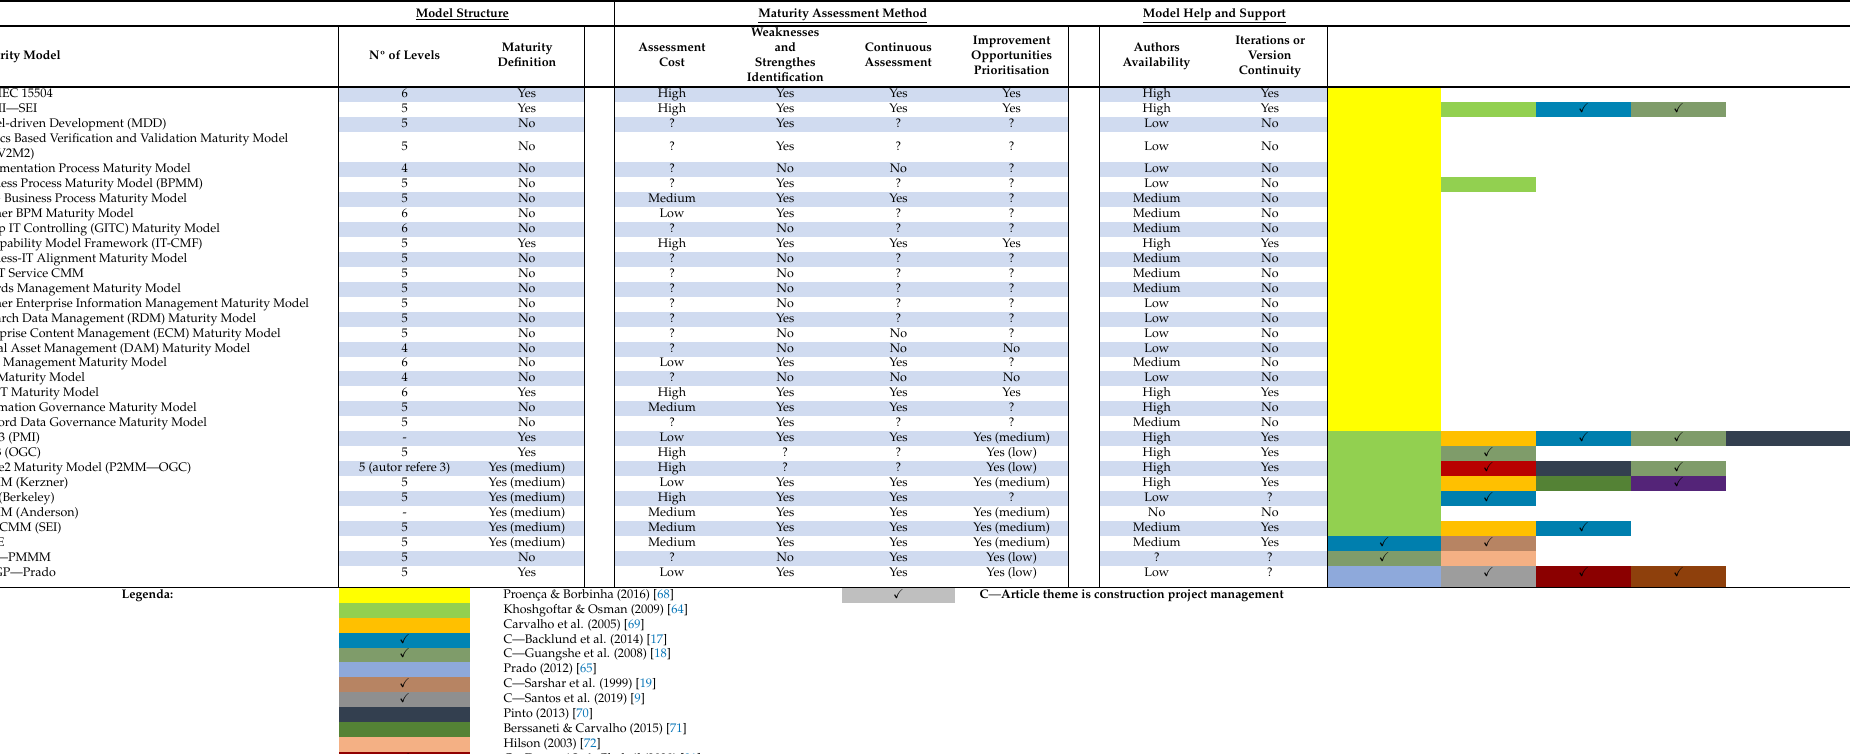
Table A1. Comparison table for the 32 identified